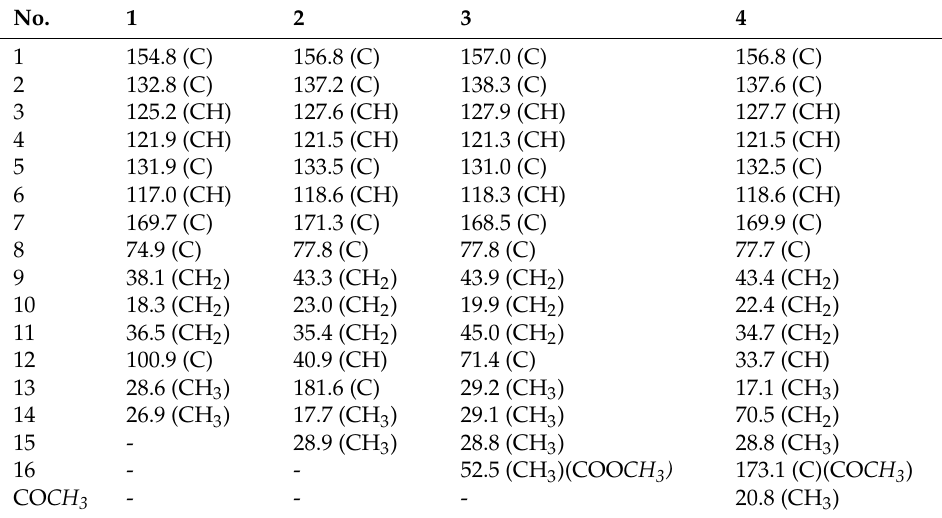
Table 1. The 13 C-NMR data of compounds 1 – 4 (100 MHz, CD 3 OD- d 4